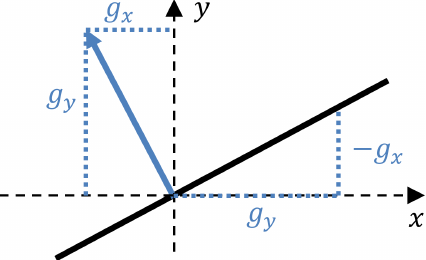
Figure 1. Sketch of the proposed measurement setup and the ray di- rection sensing component. The two coordinate systems shown rep- resent the orientation of the SUT ( x , y , z ) and ray direction sensing component ( u , v , w ).